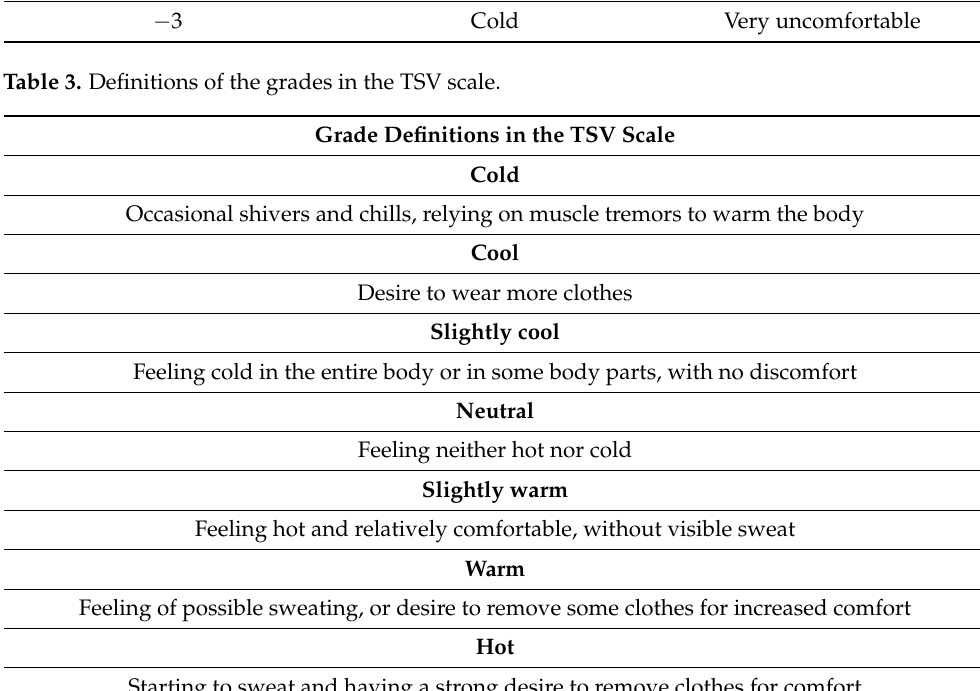
Table 3. Definitions of the grades in the TSV